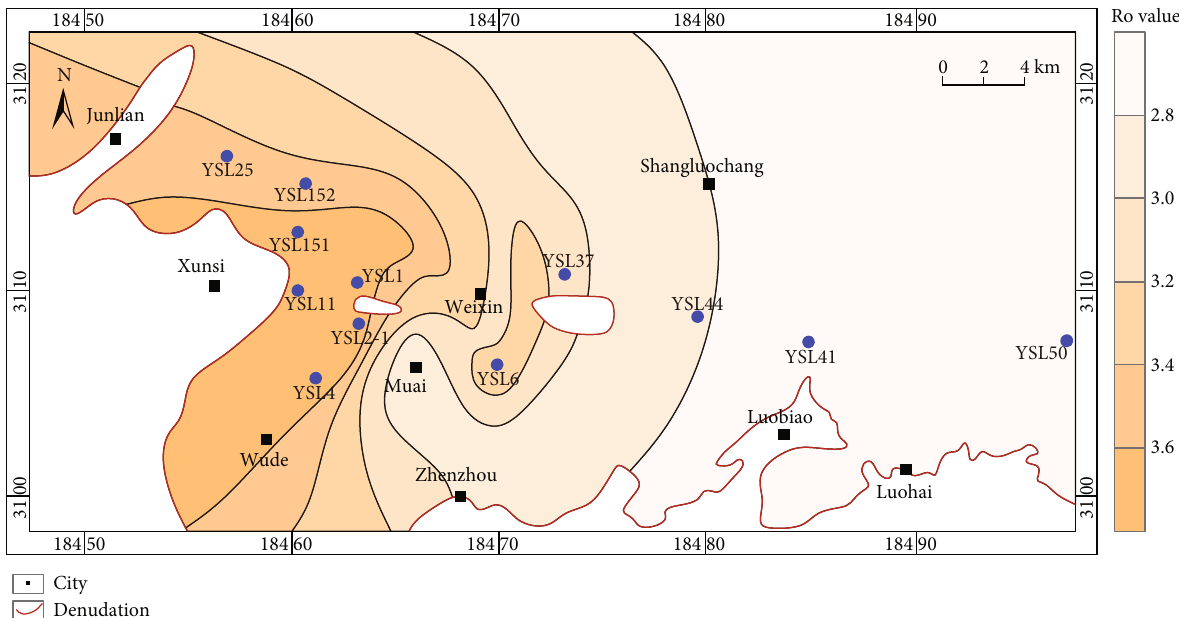
C + C 2 3 coal seam in Junlian mining area.